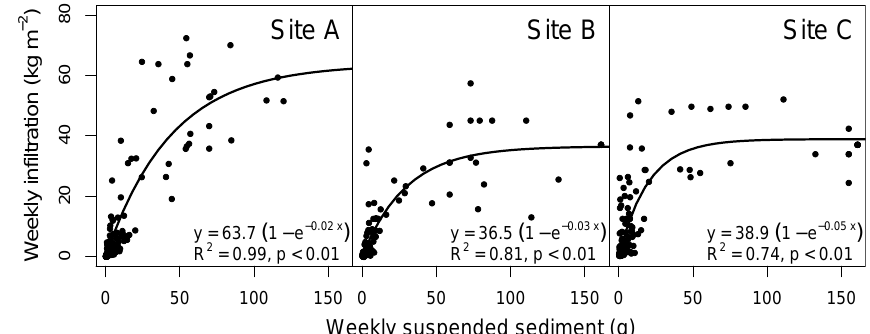
Fig. 8. Weekly sediment infiltration in relation to the total weekly SS load assessed with SS samplers at the three sites. R 2 and p of the nonlinear regressions were calculated after Zuur et al.